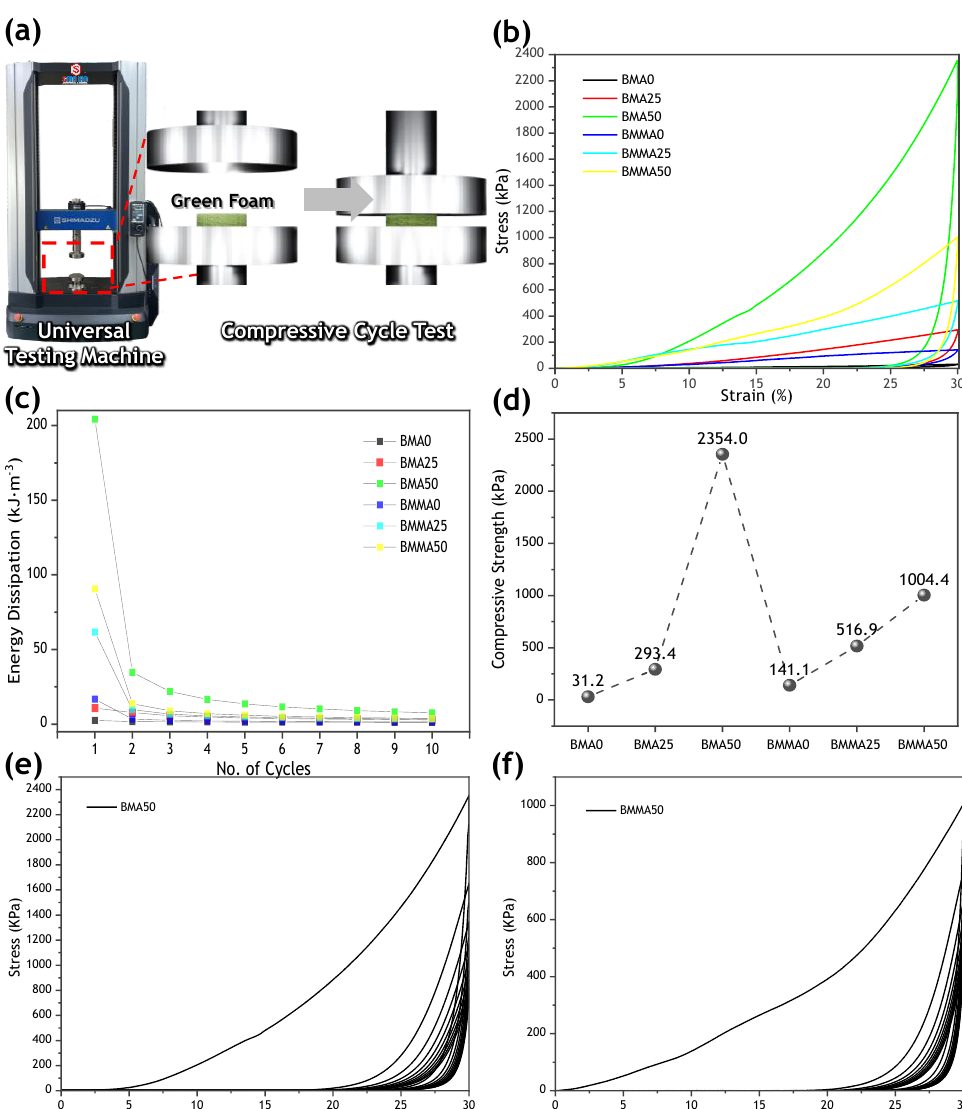
Figure 2. Energy–dissipation characteristics of acoustic energy absorbers. ( a ) Schematic of a dynamic compression cycle test. ( b ) Stress–strain curves of our samples. ( c ) Energy dissipation of the samples over 10 cycles. ( d ) Maximum compressive strength for each sample. Stress–strain curves of ( e ) BMA50 and ( f ) BMMA50 for 10 cycles.